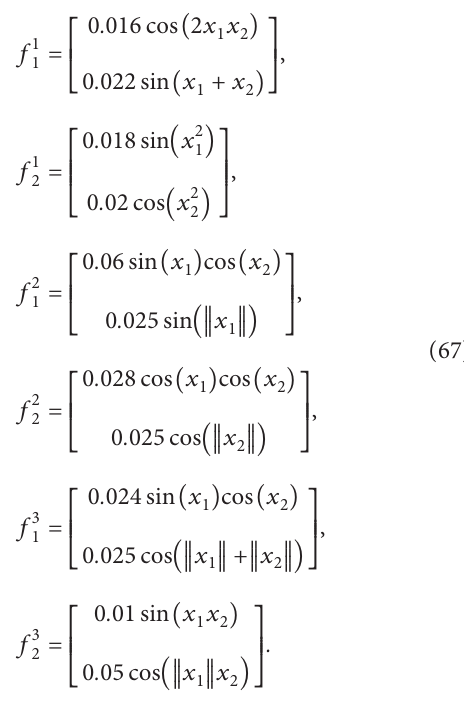
( t ) under NN-AC, DOBC, and proposed 1